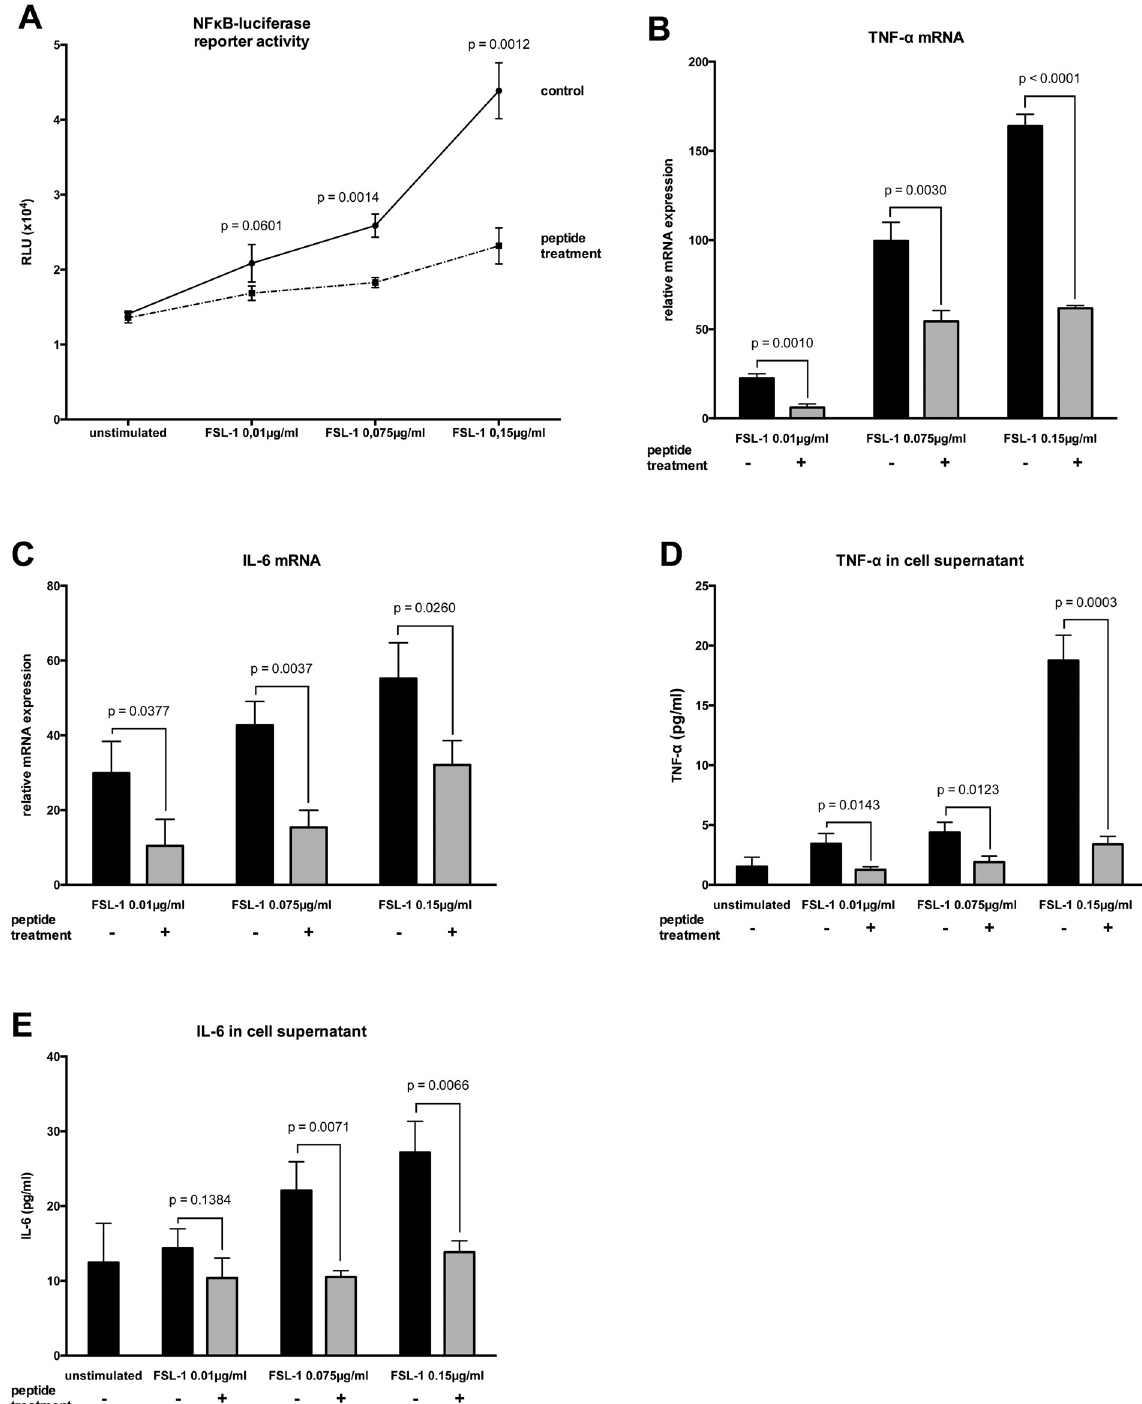
Fig 2. Inflammatory responses in HL-1 cells stimulated with FSL-1. (A) The cells were stimulated for 4 h with different concentrations of fibroblast stimulating lipopeptide-1 (FSL-1) and treated with peptide 19 – 2.5 (20 μ g/ml; dashed line) or 0.9% NaCl (control; solid line). The data are expressed as the ratio of firefly to Renilla luciferase activity in relative light units (RLU). (B and C) Following a 4-h stimulation, the induction of mRNAs encoding the pro- inflammatory TNF- α (B) and IL-6 (C) cytokines was monitored by RT-PCR. The inductions shown are normalized to non-stimulated cells. (D and E) Secreted protein concentrations of TNF- α (D) and IL-6 (E) were determined in supernatants using ELISA. Data represent the mean ± SD of triplicate samples, representative of three independent experiments. P values represent statistically significance between untreated (control) and treated cells with peptide 19 – 2.5 (peptide treatment) using multiple t-test with Holm- Š ídák